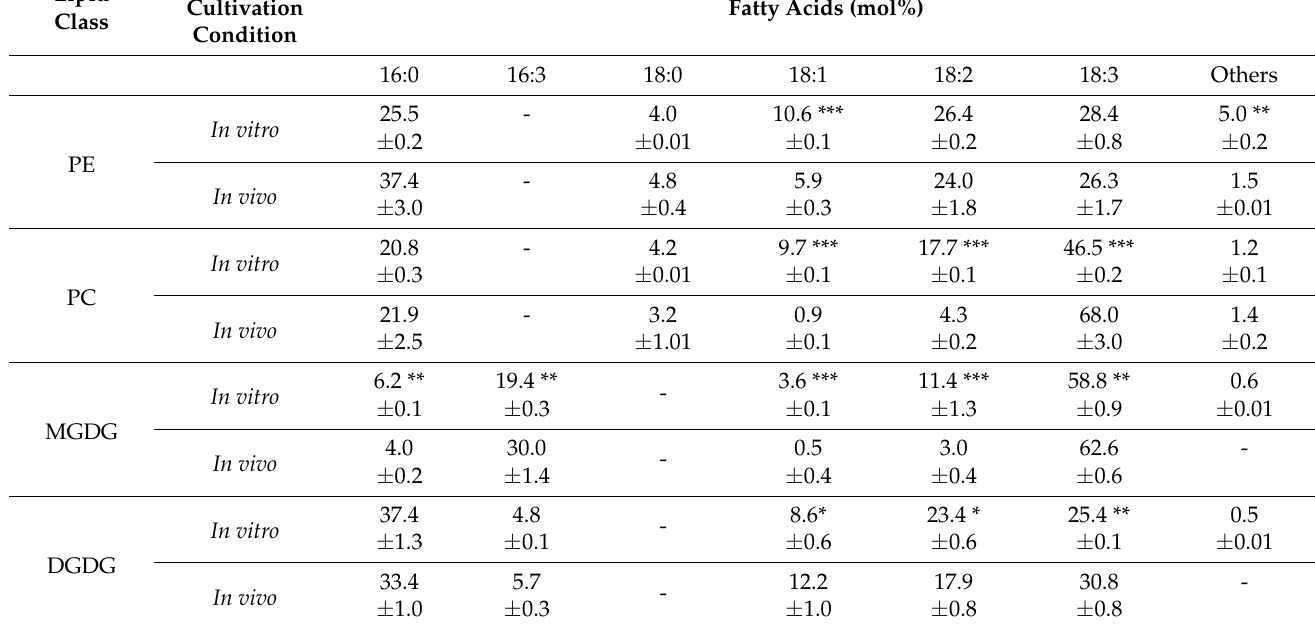
Table 1. Distribution of different fatty acids in major/chosen phospholipids and galactolipids present in C. sativa leaves cultured in in vivo and in vitro conditions. In “others” pool, 20:1, 20:2, 20:3, 22:0, 24:0 and 24:1 are present. Mean values and SD are presented (data from at least three independent assays). Asterisks indicate significant difference between relative amounts of fatty acids present in each analysed lipid class in leaves cultivated in vivo and in vitro in a two-tailed